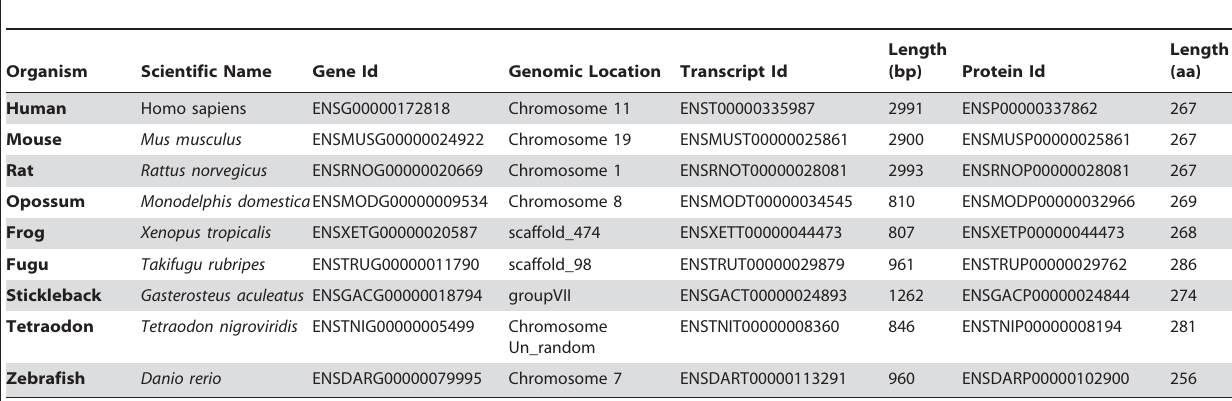
Table 1. List of OVOL1 genes from selected vertebrate genomes, identified from Ensembl database release 58 (May